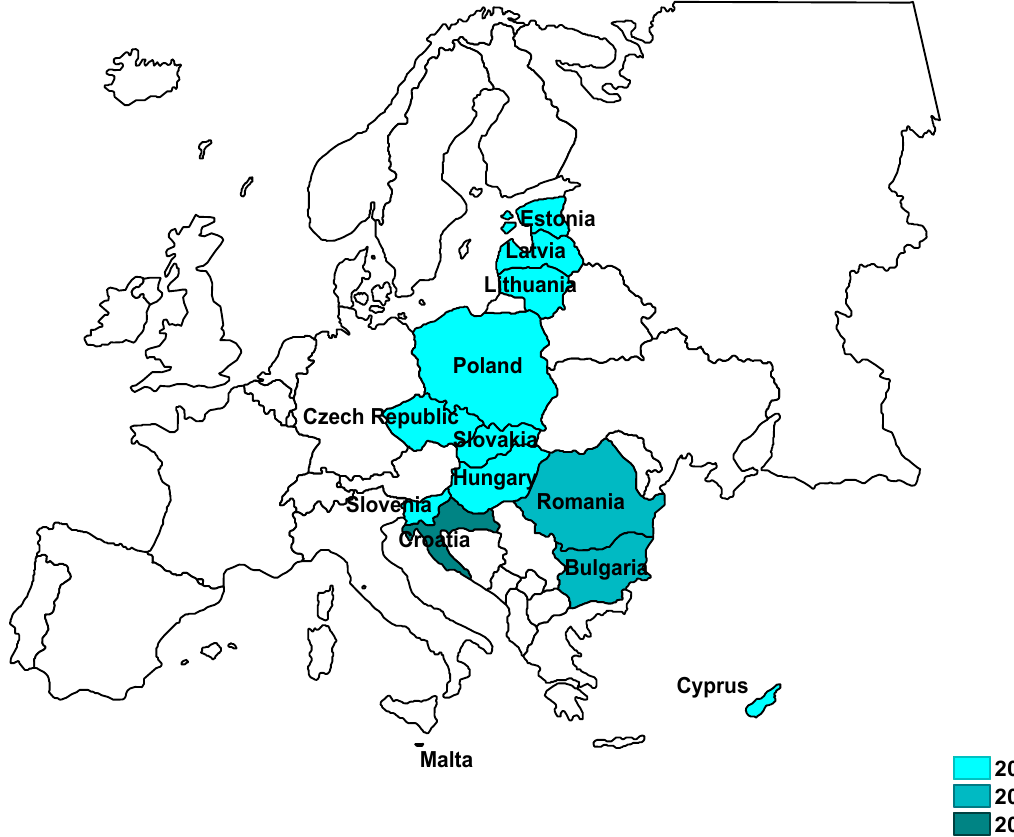
Figure 2. Map of the studied countries with the year they joined the EU.